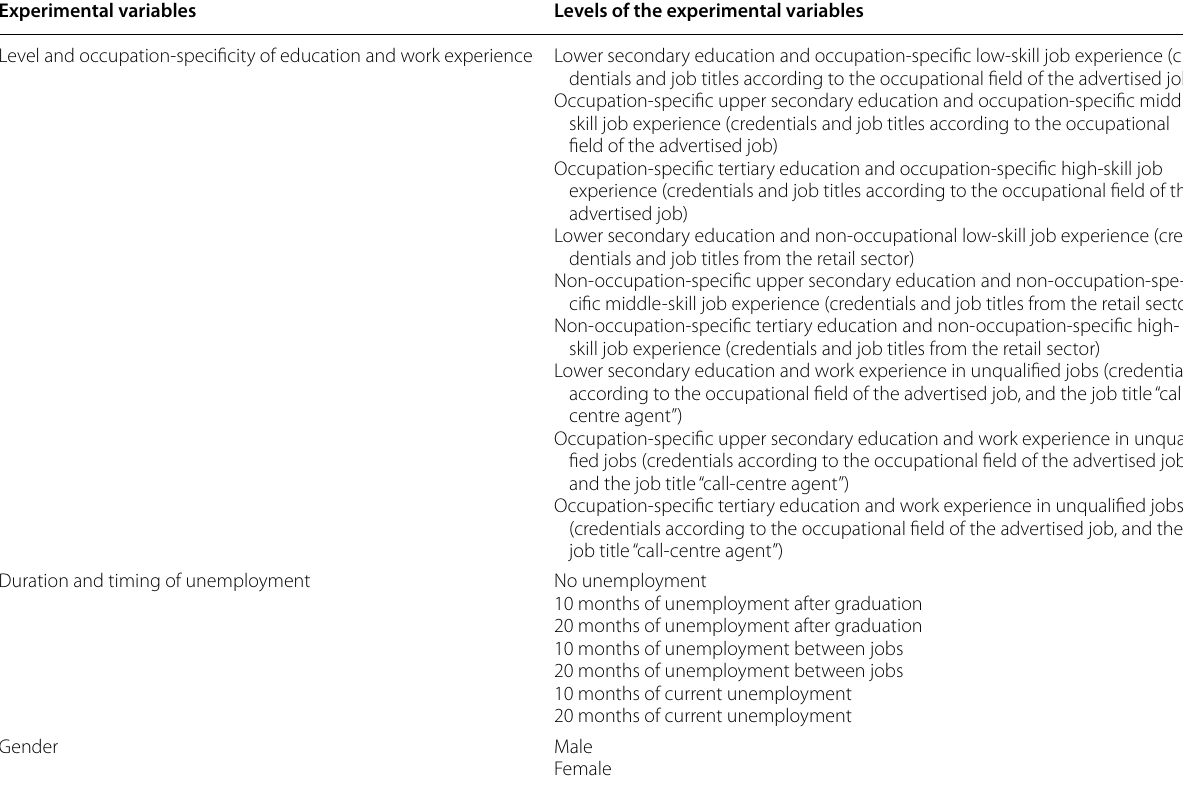
Table 2 Experimentally varied characteristics of the hypothetical applicants Experimental variables Levels of the experimental